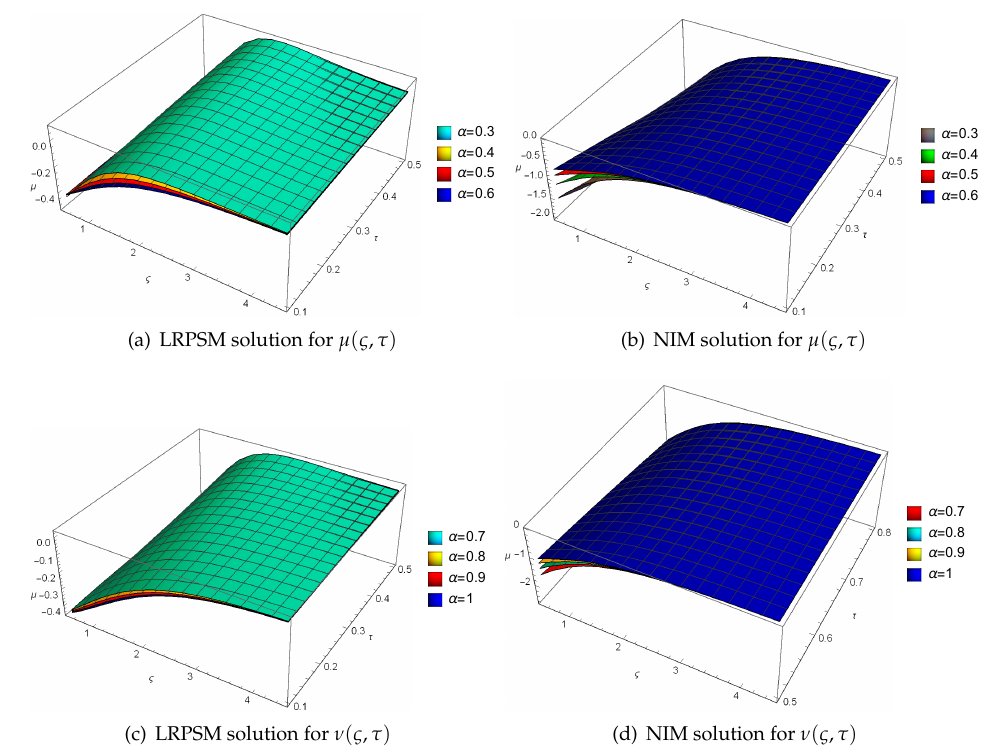
Figure 2. Graphical representations of the LRPSM and NIM solutions for µ ( ς , τ ) and ν ( ς , τ ) in three dimensions are shown at various levels of fractional